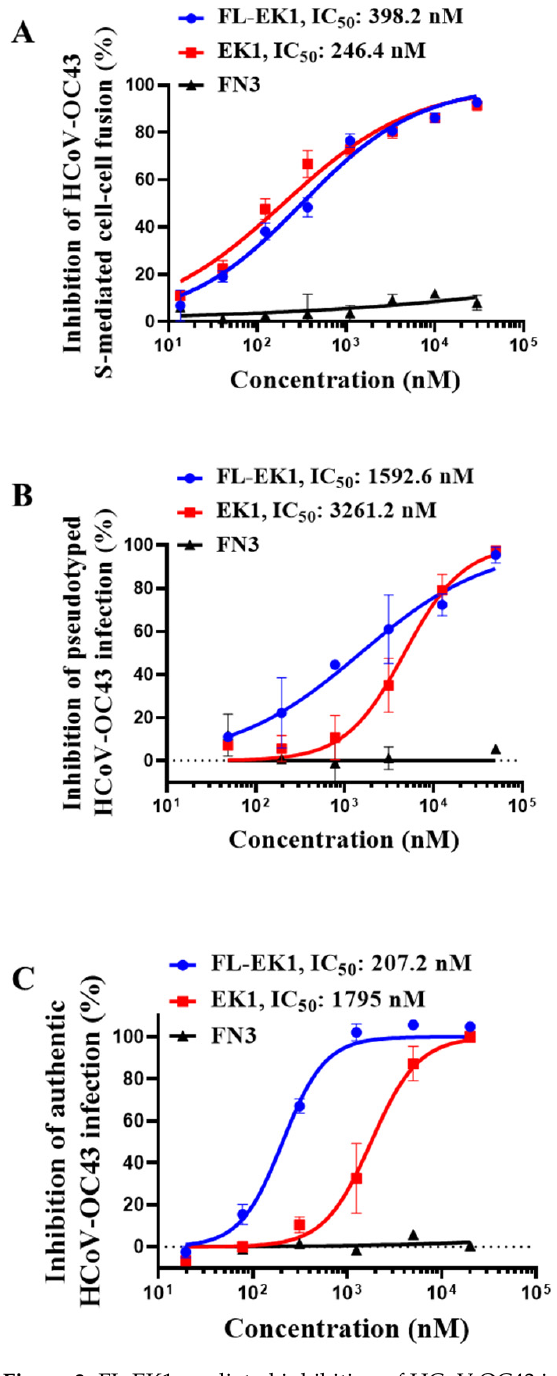
Figure 3. FL-EK1-mediated inhibition of HCoV-OC43 infection. ( A ) FL-EK1-mediated inhibition of HCoV-OC43 S-mediated cell–cell fusion. ( B ) FL-EK1-mediated inhibition of pseudotyped HCoV- OC43. ( C ) FL-EK1-mediated inhibition of authentic HCoV-OC43 infection. Samples were tested in triplicate, and the experiment was repeated three times. Data from a representative experiment are presented as mean ± SD.